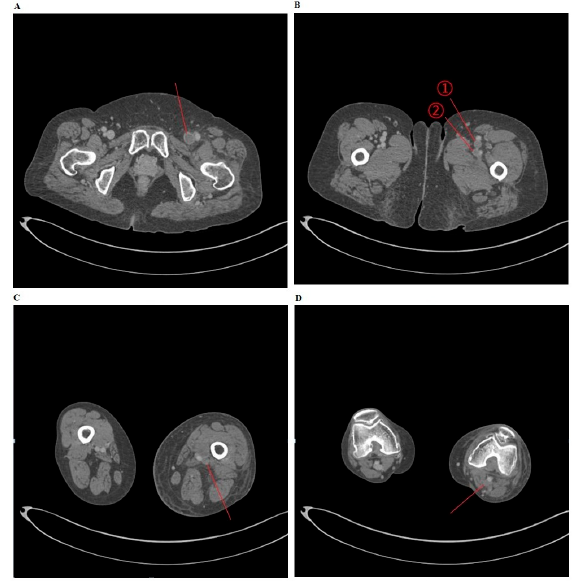
Figure 1. Deep vein thrombosis (DVT) on computed tomography (CT) venography.